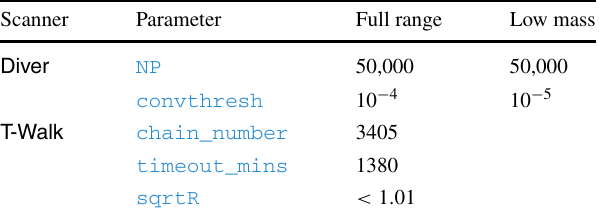
Table 4 Sampling parameters for global fits of the Z 2 - and Z 3 - symmetric scalar singlet models in this paper